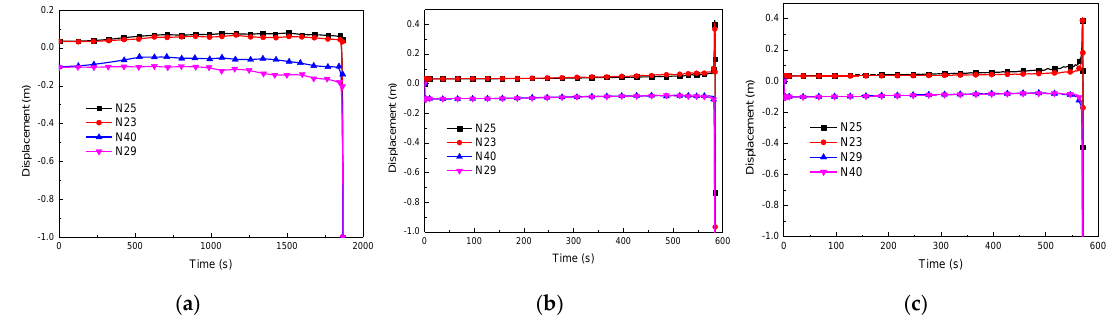
Figure 20. Time-history curves of displacement of key nodes in different fire conditions. ( a ) Fire location I; ( b ) fire location II; ( c ) fire location III.